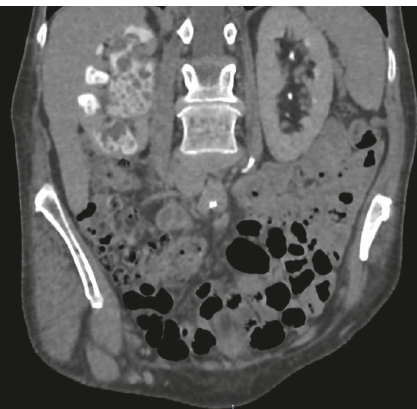
Figure 1: Contrast enhanced CT scan of renal tract, in coronal plane showing appearance of matrix stone throughout the right kidney. Figure 2: Retrograde pyelogram of right kidney with filling defects